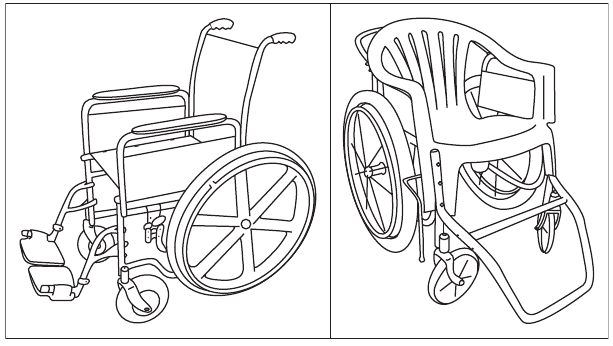
Source : Figure provided by Elsje Scheffler. FIGURE 1: Examples of the basic folding (left) and non-folding (right) wheelchairs provided by donor organisations.